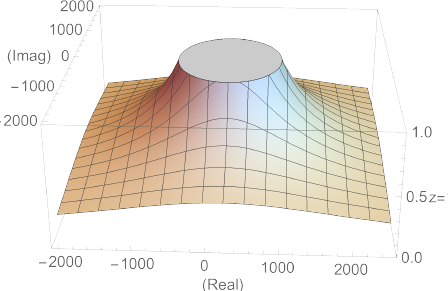
Figure 1. Strange fixed point stability region where z “